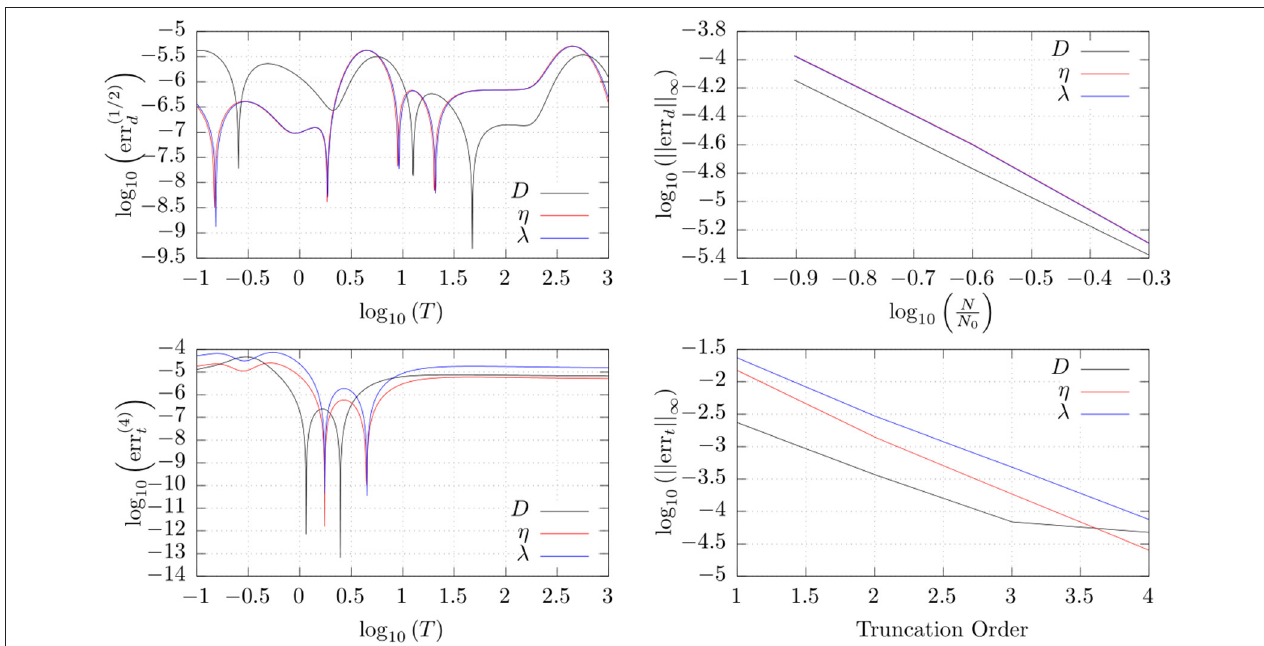
FIGURE 4 | Discretization and truncation errors of the calculated transport coefficients of the Lennard-Jones/spline fluid. Top left: the estimated discretization error of a grid with half the number of points as the largest grid used. Top right: The variation of the inf-norm of the discretization error with the number of grid points, proportional to the size parameter N . Bottom left: the estimated truncation error by neglecting 5th order terms and higher (truncation order 4) in the Sonine polynomial expansions. Bottom right: The variation of the inf-norm of the truncation error with the truncation order.